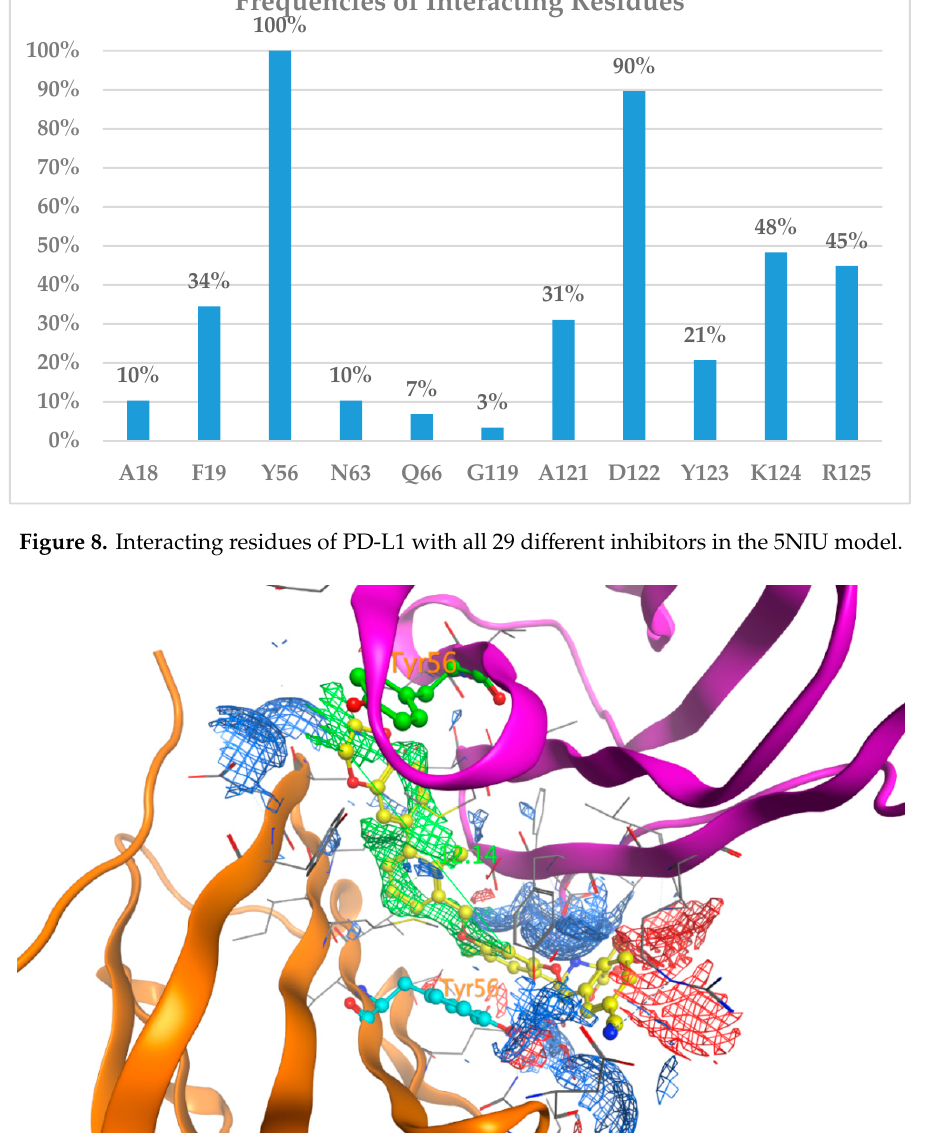
Figure 9. Electrostatic surface of the binding pockets of the PD-L1 with BMS-1001 ( 1 , 5NIU). The hydrophobic region is depicted as green; H-bond acceptor, red; and H-bond donor, blue. Chain D is colored with a magenta secondary structure, whereas Chain C is in orange color. Tyr56 of chain C is highlighted in cyan and Tyr56 of Chain D in green. The distance between the two aromatic rings interacting with Tyr56 of chains C and D is 12.14